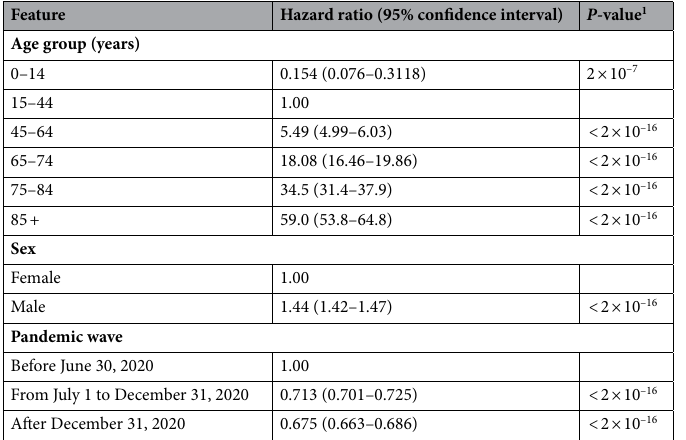
Table 4. Factors associated with death in hospitalized COVID-19 patients in the Italian national database. Among hospitalized persons, 2448 cases were excluded due to incomplete or erroneous data, for a total of 412,942 SARS-CoV-2-positive subjects analyzed and 85,503 deaths within 30 days of diagnosis. 1 Multivariable weighted Cox analysis (non-proportional hazards